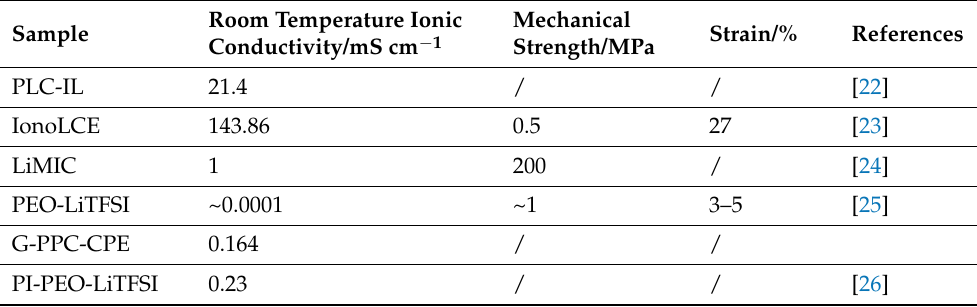
Table 1. Comparison of ionic conductivity and mechanical properties between liquid-crystal-based polymer electrolytes and conventional polymer electrolytes. Room Temperature Ionic Sample Conductivity/mS cm −